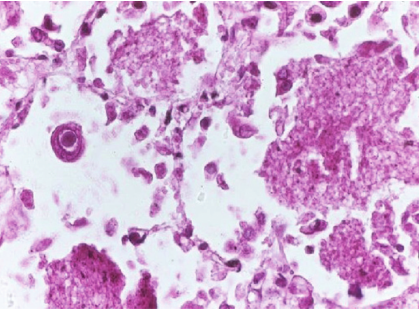
Figure 1: CMV pneumonitis in the patient—autopsy finding (hem- atoxylin-eosine, 100x